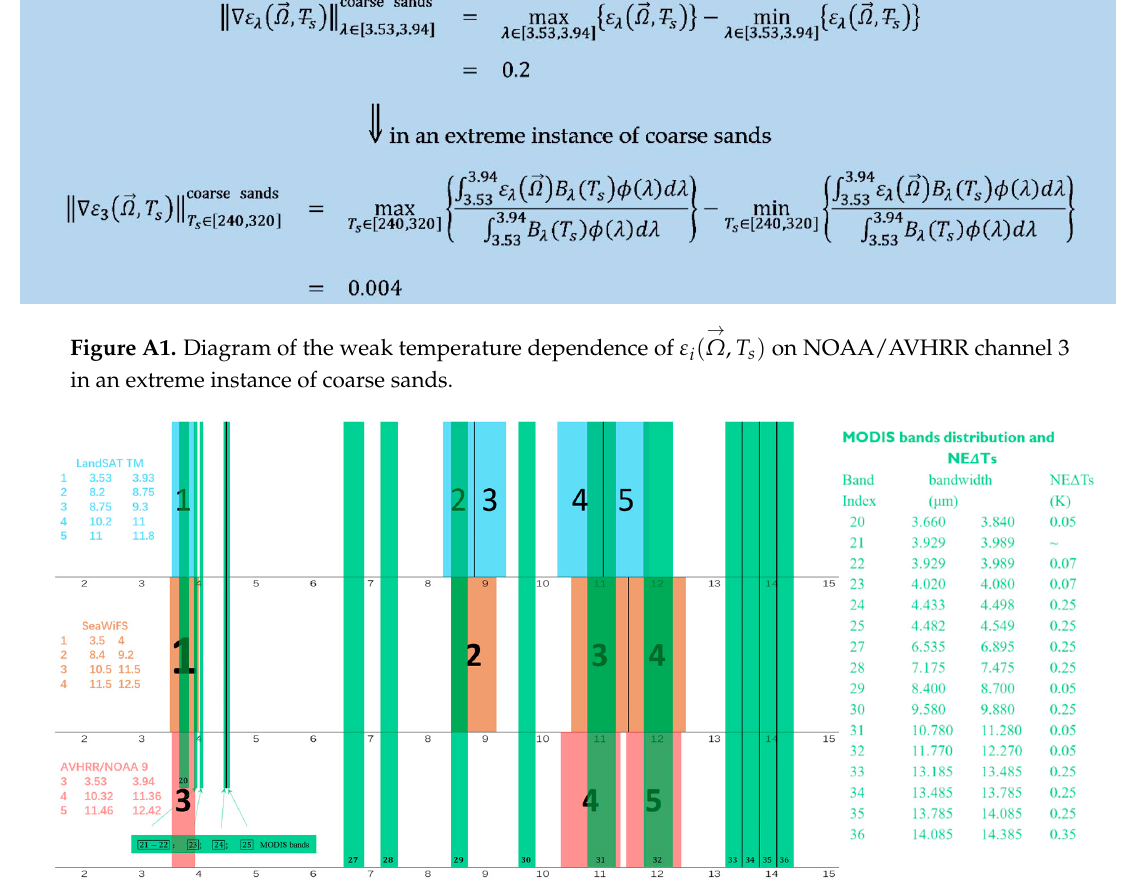
Figure A2 . Illustration of the commonly used instruments’ IR channel distributions, which were well